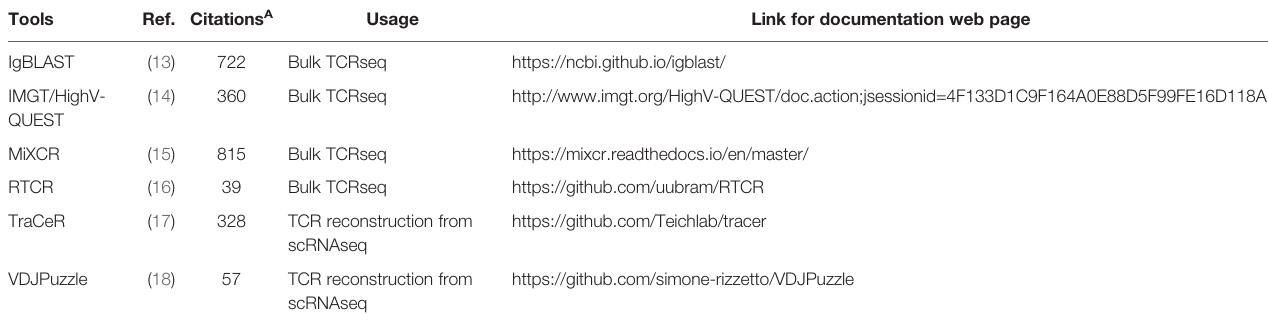
TABLE 2 | Computational tools for TCR-seq data analysis. Tools